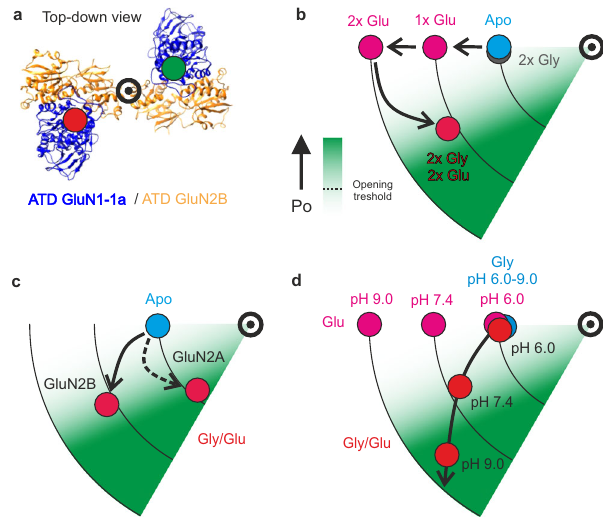
Fig. 6 Schematic representation of ATD conformational transitions. a Top-down view of the ATD domain (5IOU [https://doi.org/10.2210/ pdb5IOU/pdb]). Red and green fi lled circles show approximate positions of the SNAP tags labeled by donor and acceptor dyes, respectively. Bullseye denotes the center of rotation. b Model of NMDAR activation by glycine and glutamate. c Model of NMDAR activation for GluN2B- and GluN2A- containing receptors. d Model of NMDAR modulation by pH in the presence of Gly, Glu, and Gly/Glu. Maximal degree of rotation (achieved in Gly/Glu, pH 9.0) corresponds to 45° rotation of ATD dimers after receptor activation 39